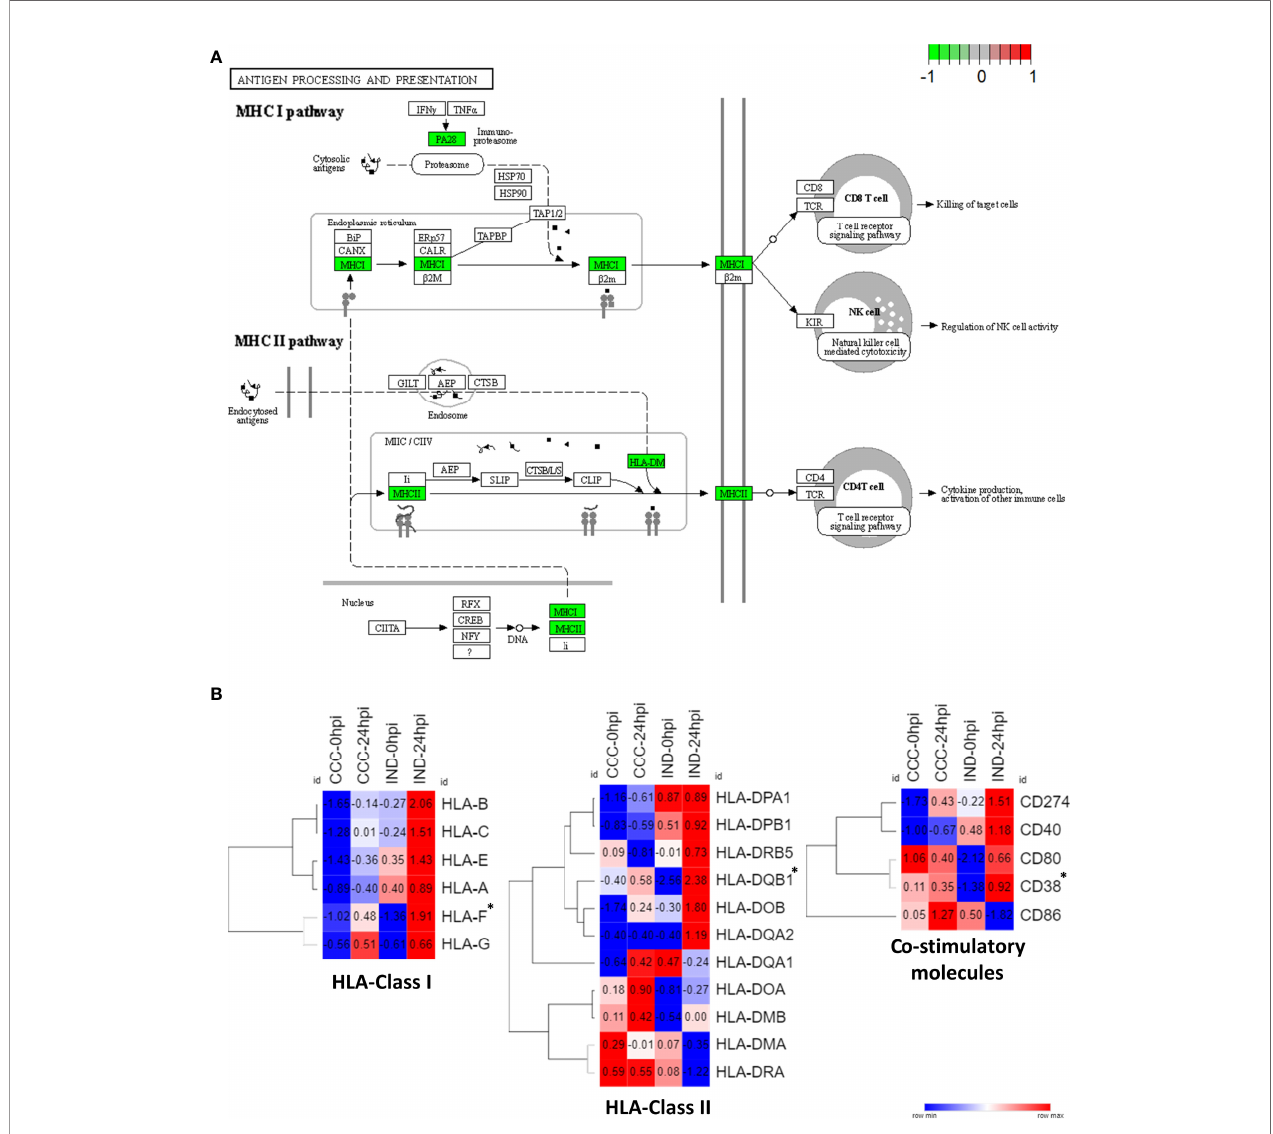
FIGURE 6 | HLA expression pathways in IND and CCC cardiomyocytes. (A) DEGs were plotted against KEGG antigen processing and presentation pathway and both MHC I and MHC II pathways had a positive association with IND (green – IND association; red – CCC association). (B) Heat maps showing the normalized expression of HLA Class I and Class II genes across all conditions. *DEGs with statistical signi fi